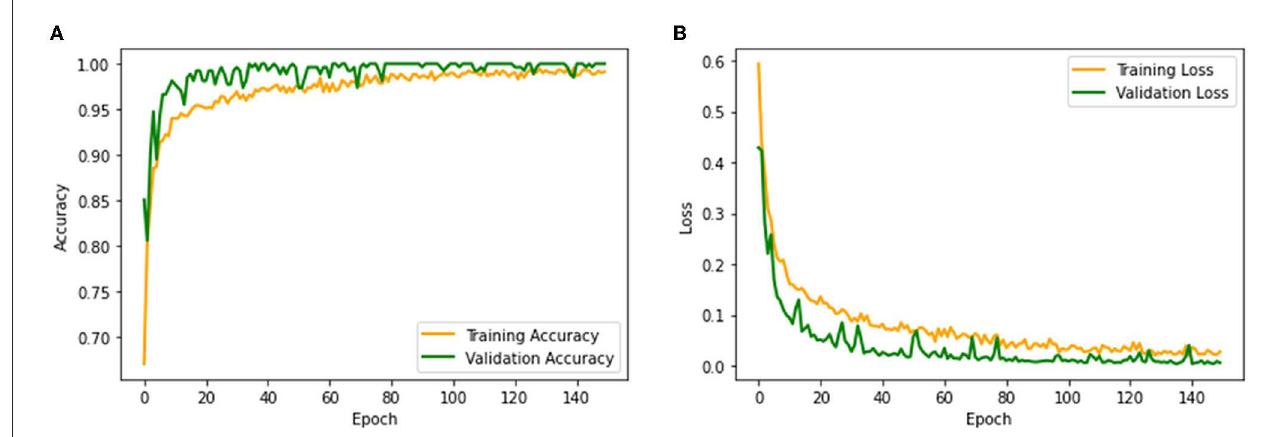
FIGURE5 Convergence of training and validation process. (A) Accuracy. (B)